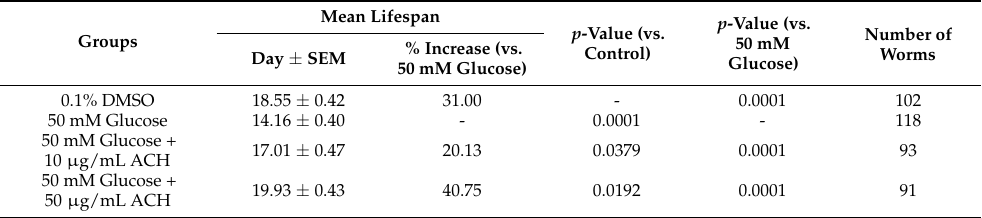
Table 2. Results and statistical analyses of lifespan of C. elegans treated with high glucose and ACH.